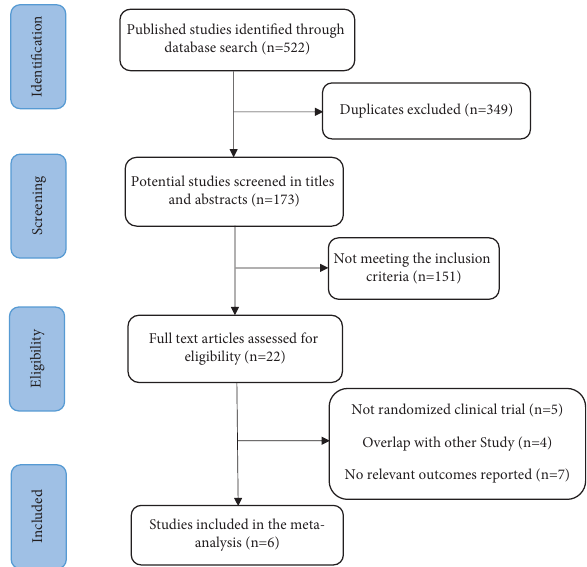
Figure 1: Flow chart of the literature searching